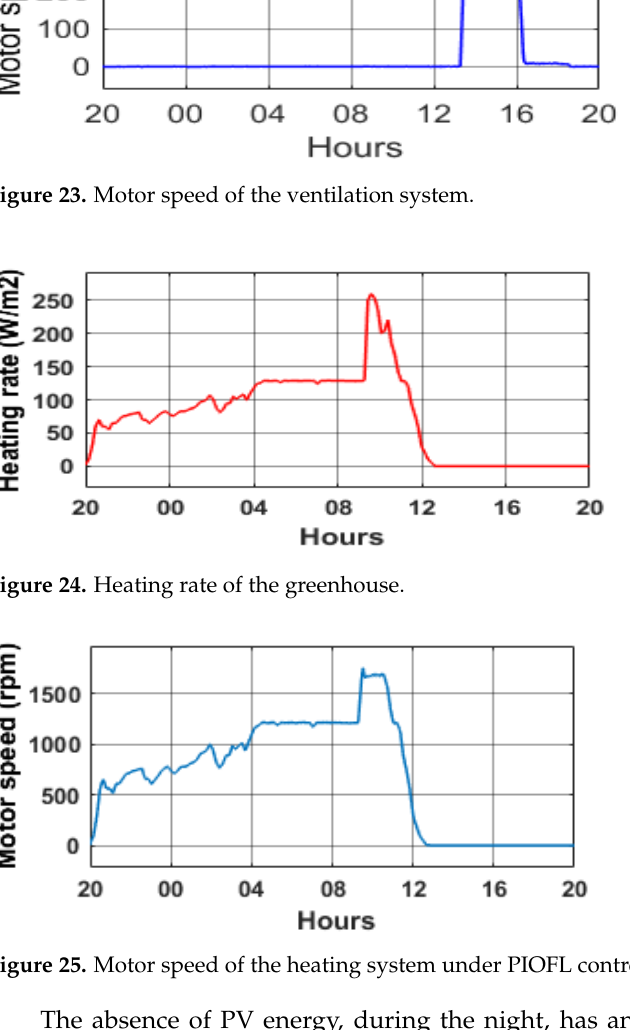
Figure 23. Motor speed of the ventilation system.